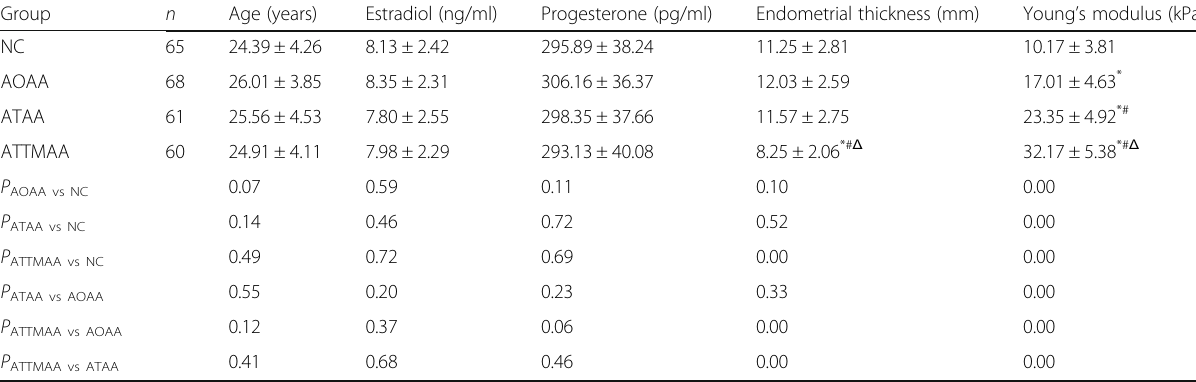
Table 1 Parameters in different